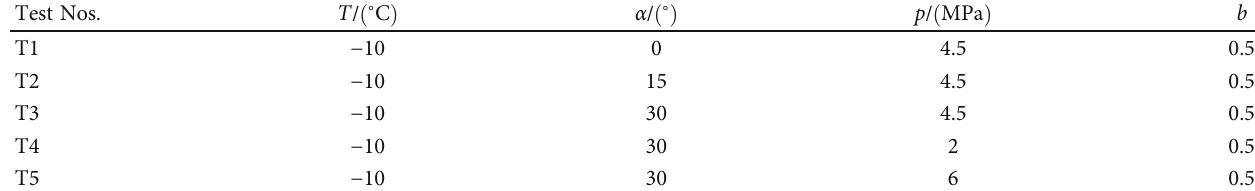
Table 3: Summay of directional shear tests.